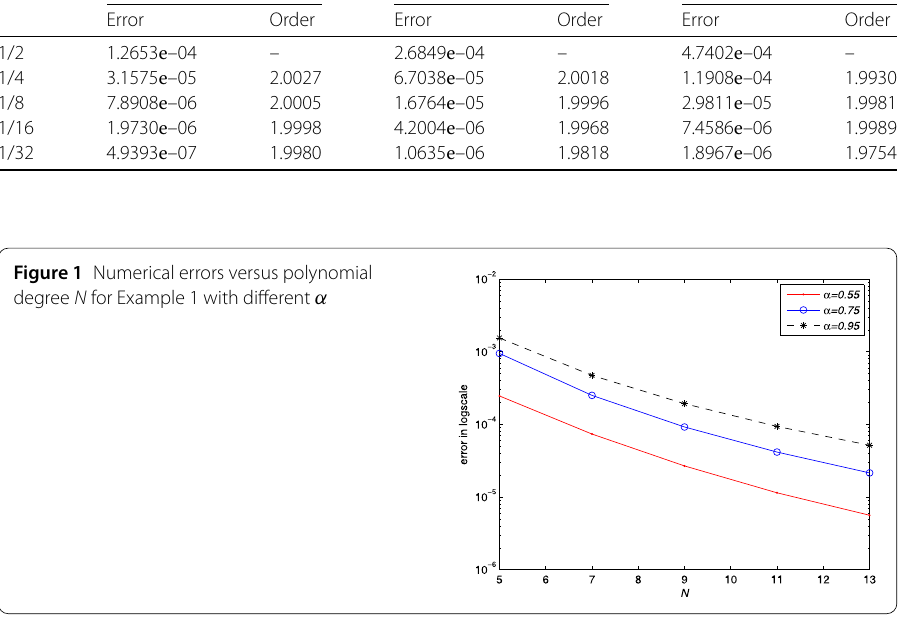
Table 3 The L 2 errors and temporal convergence order with different α and τ for Example 1, N = 50